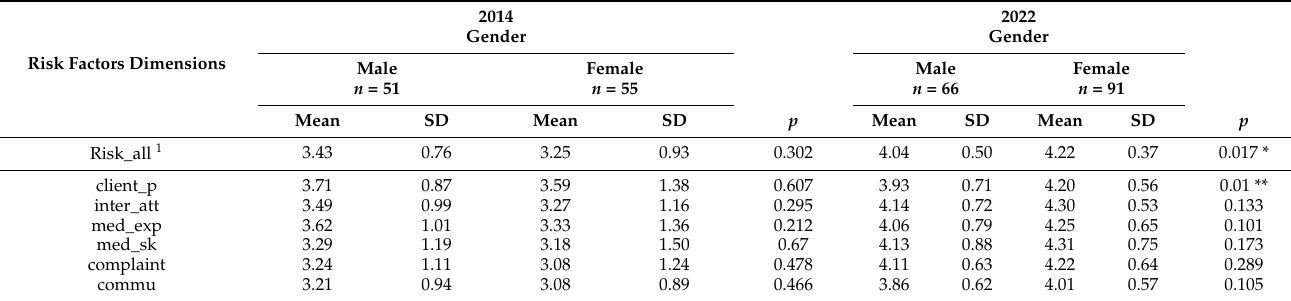
Table 6. The risk factor perception differences by gender in 2014 and 2022.